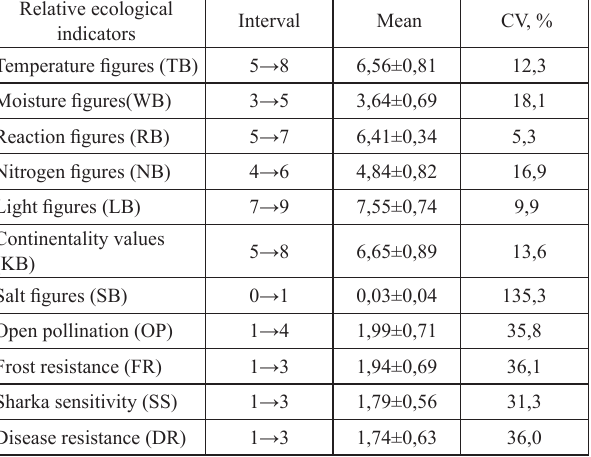
Table 2: Relative ecological indicator values of apricot cultivars Table 3: Comparison of ecological and biological indicator